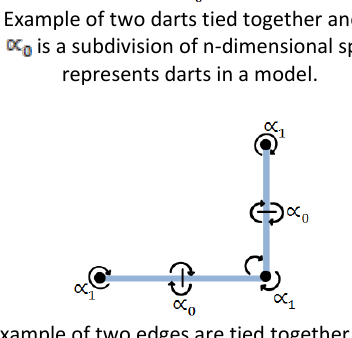
Figure 2 . Example of two edges are tied together. is a set of distinct edges that share same